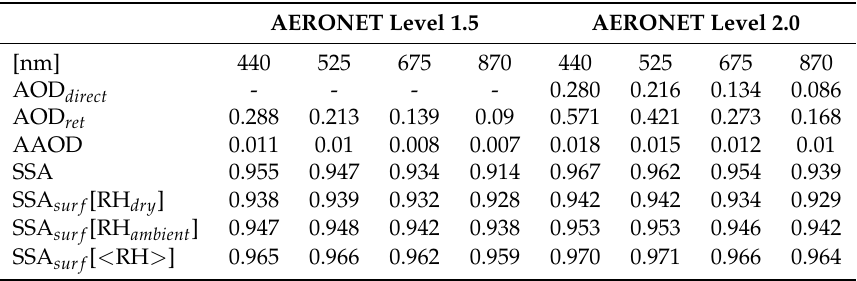
Table 1. Mean aerosol optical properties between June and August 2015 at SolarAOT station for in-situ (aethalometer + nephelometer) and Aerosol Robotic Network (AERONET) level 1.5 and 2.0 and four wavelengths (440, 525, 675, and 870 nm). AOD direct and AOD ret corresponds to direct and inversion product, absorbing aerosol optical depth (AAOD) and single scattering albedo (SSA) are AERONET retrievals while SSA surf ( RH dry ), SSA surf ( RH ambient ), SSA surf (<RH>) are surface SSA for dry, ambient and mean RH in the aerosol mixing layer, respectively. AERONET Level 1.5 AERONET Level 2.0